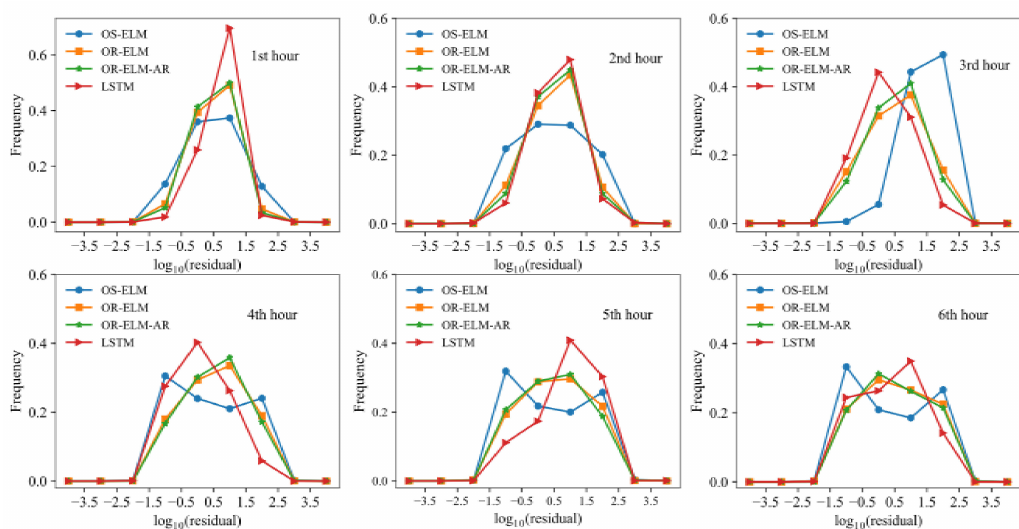
Figure 9. Residual distributions of the extreme learning machine (OS-ELM), online recurrent extreme learning machine (OR-ELM), OR-ELM-AR and LSTM